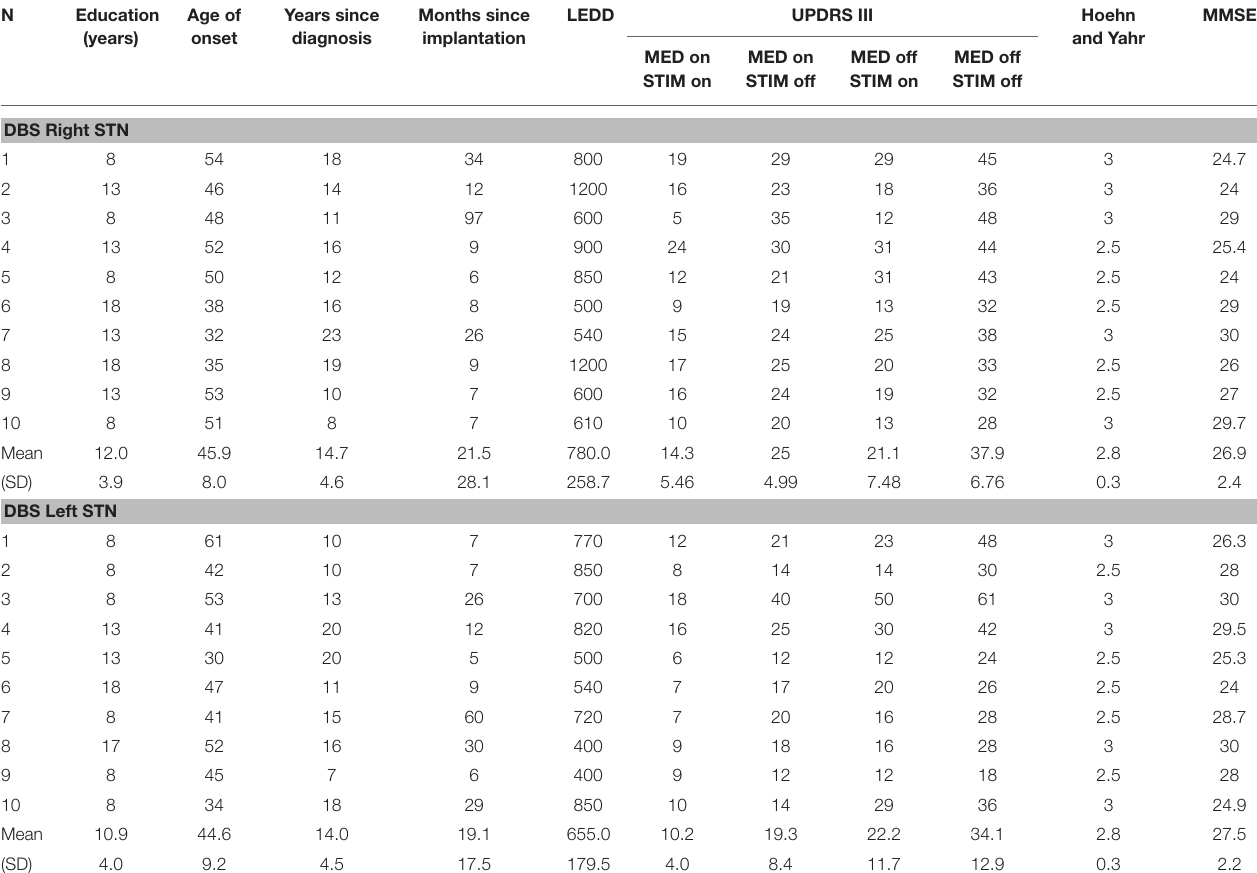
TABLE 1 | Clinical data of Parkinson disease (PD) patients with deep brain stimulation (DBS) implant in the right and left subthalamic nuclei (STN) participating in the experiment.